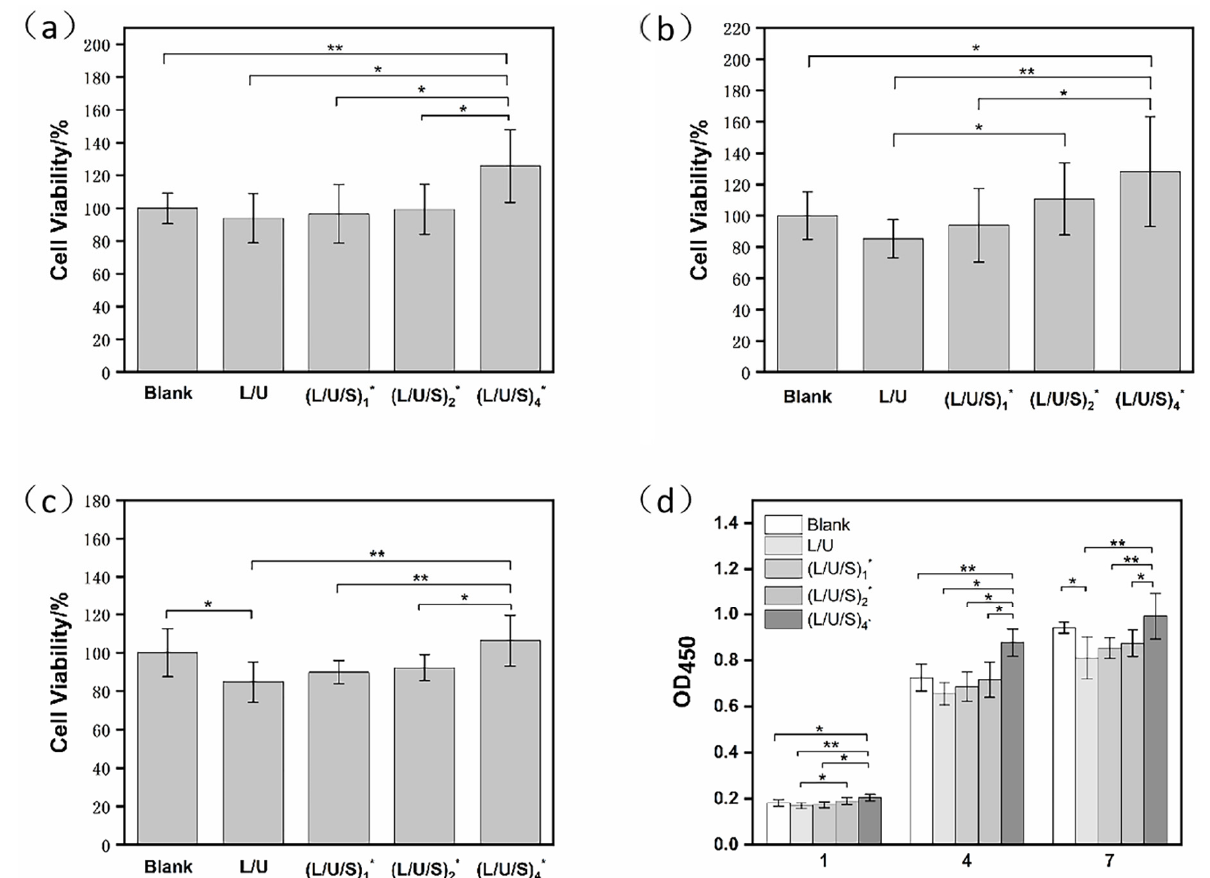
Figure 7. CCK-8 determined cell viability in four groups of electrospun membranes at 1 day ( a ), 4 days ( b ), and 7 days ( c ), and cell proliferation response OD value ( d ). (L/U/S) 1* , (L/U/S) 2* , (L/U/S) 4* referred to the sample after (L/U/S) 1 , (L/U/S) 2 , (L/U/S) 4 were cross-linked, respectively. * p < 0.05, ** p <